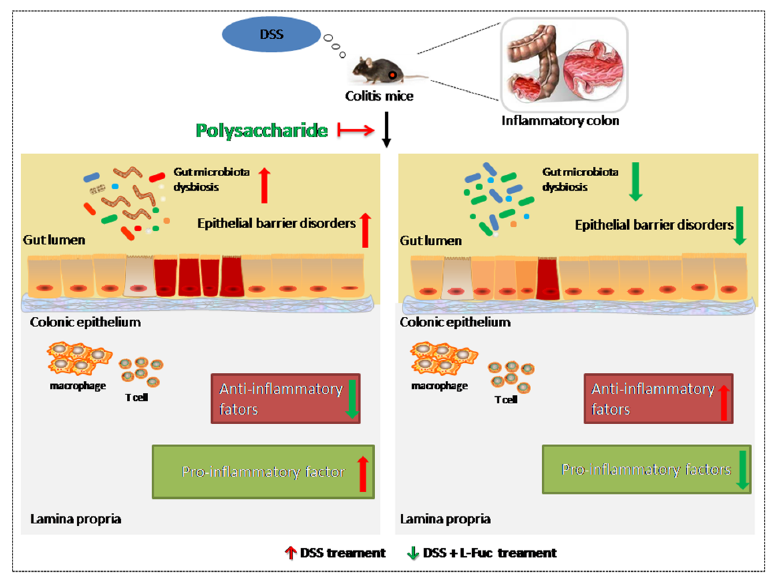
Figure 1. Polysaccharides can treat colitis in three aspects: regulating intestinal flora, repairing epithelial barriers, and regulating inflammatory factors. Table 1. The mechanisms of different polysaccharides on experimental colitis.